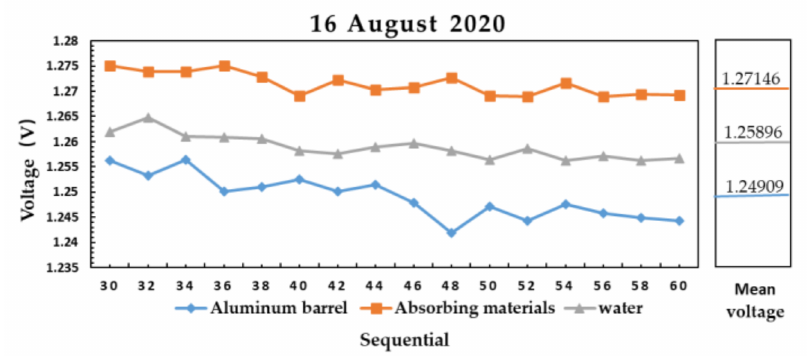
Figure 15. The result of microwave radiometer measuring aluminum plate, absorbing material, and water sealed in aluminum barrel on 16 August